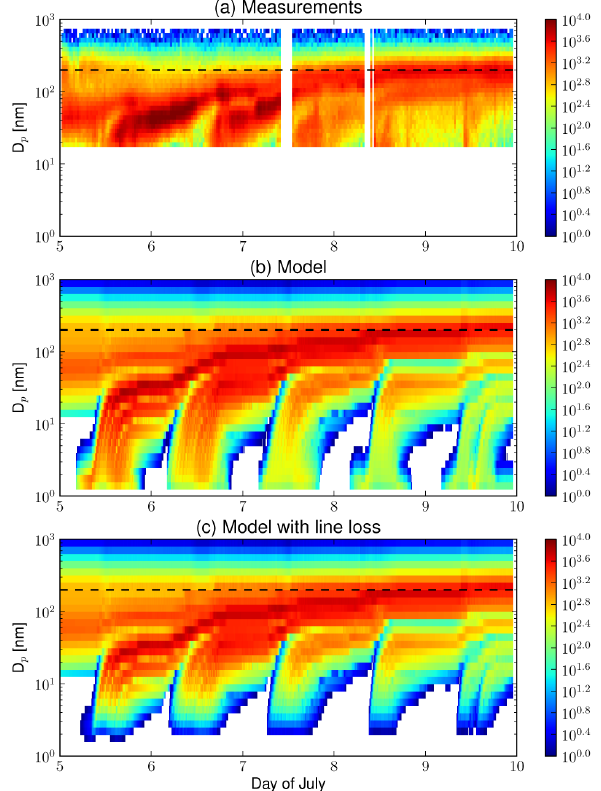
Fig. 8. (a) Measured SMPS size distribution (dN/dlog D p [cm − 3 ]) at Raven’s Nest vs. time. (b) Simulated size distributions vs. time.